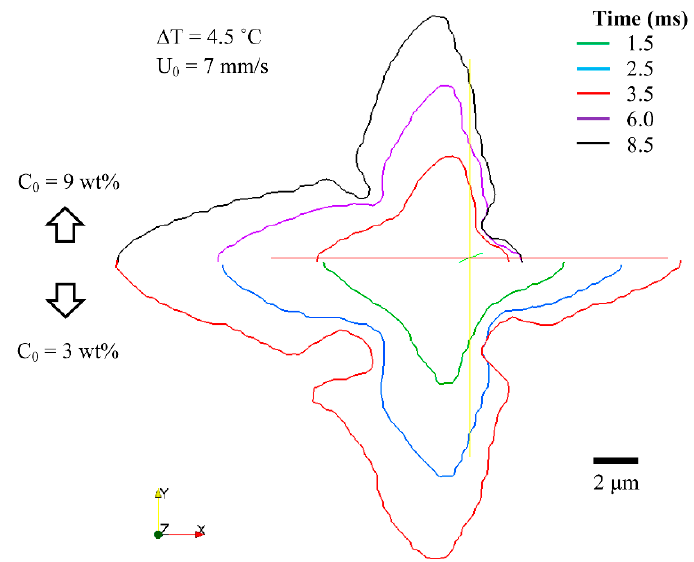
Figure 15. Effect of alloy composition on the dendritic morphology under inlet melt velocity of U 0 = 7 mm/s, and ∆ T = 4.5 °C. (Top) Al-9 wt % Cu, and (bottom) Al-3 wt % Cu. Different colors represent different simulated times.